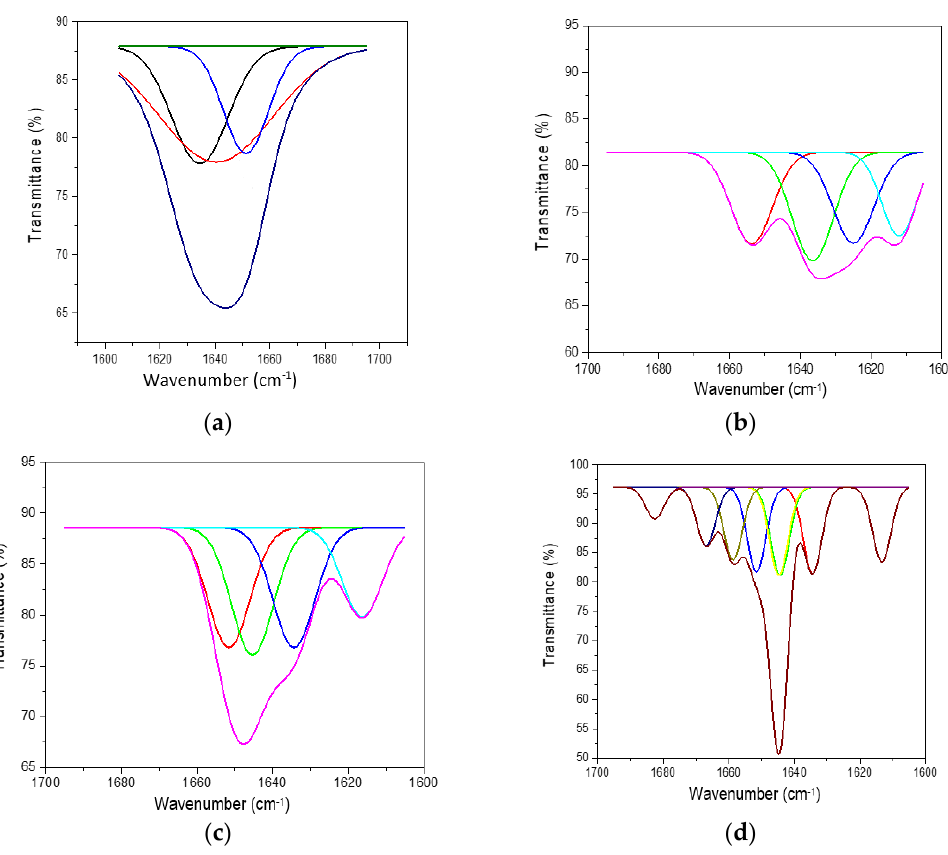
Figure 5. Deconvoluted amide I band for ( a ) HK, ( b ) PRO, ( c ) ESPE, and ( d ) VALKE. Table 2. Amide I band deconvolution for the keratin samples.